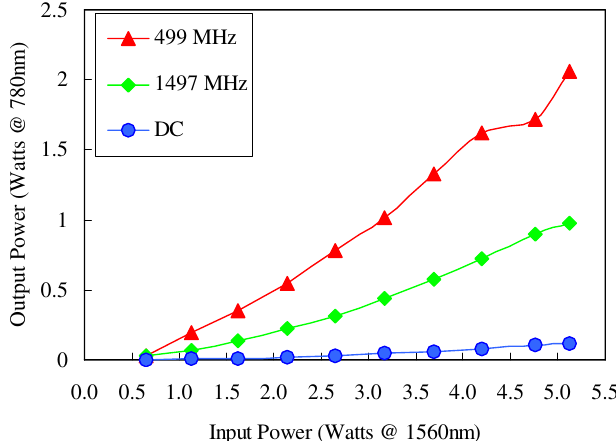
FIG. 2. (Color) Output power of the fiber-based laser system at 780 nm versus input power from the seeded ErYb-doped fiber amplifier at 1560 nm. Three different seed conditions were tested; DC and rf-pulsed input at 499 and 1497 MHz.